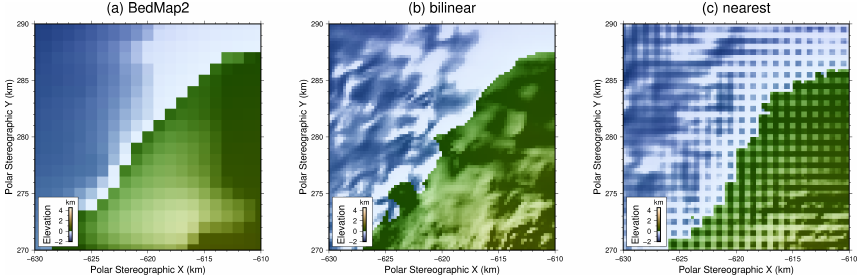
Figure 2. Comparison of nearest-neighbor and bilinear interpolation applied directly on an upsample